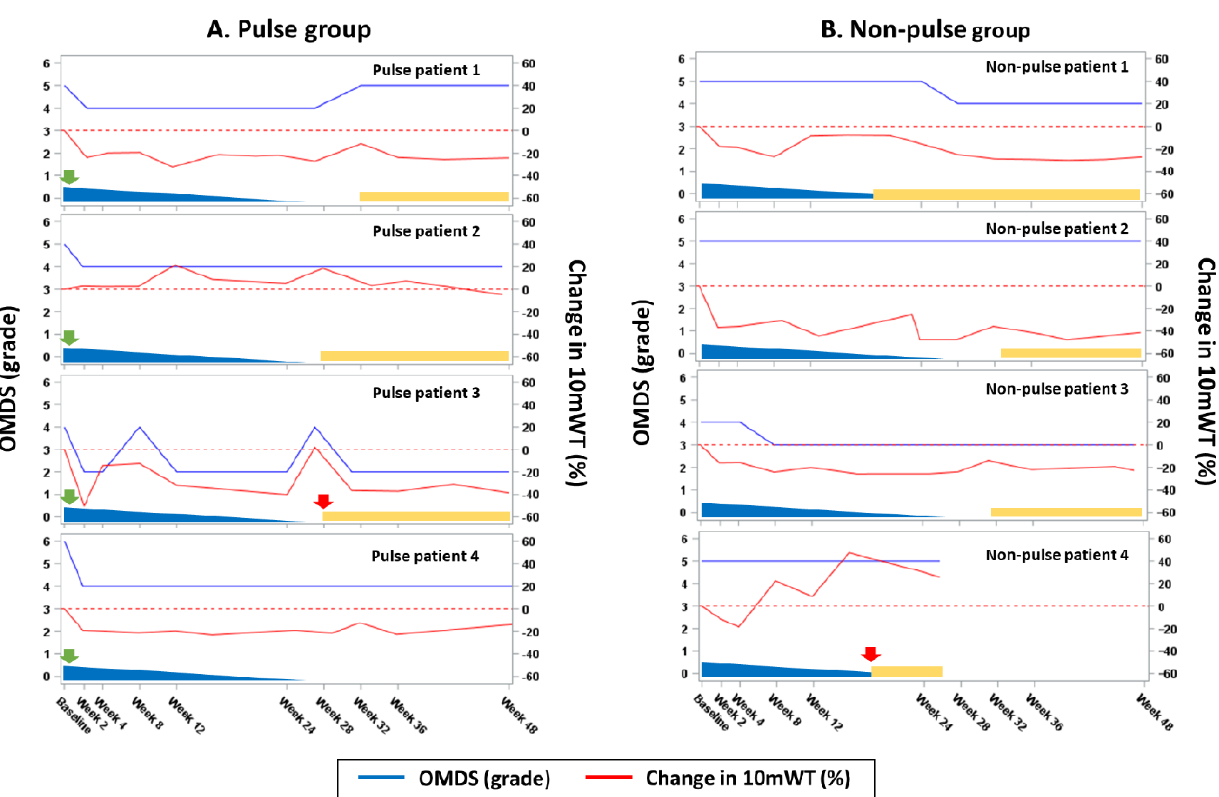
Figure 2. Primary endpoint in rapid progressors. ( A , B ) OMDS and percent changes in the 10 mWT from baseline are presented. The red dotted lines indicate the baseline 10 mWT (0% line). The green arrows (intravenous methylprednisolone) and blue triangles (oral prednisolone) represent steroid treatment. The red arrows (intravenous methylprednisolone) and yellow rectangles (oral prednisolone) represent additional treatment for worsening gait function. OMDS, Osame Motor Disability Score; 10 mWT, 10 m walking time. Table 3. Main outcomes in rapid progressors.